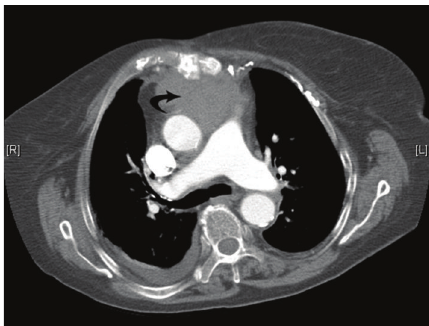
Figure 2: Axial slice from contrast-enhanced CT study demonstrat- ing direct communication and erosion of the abscess cavity into the anterior ascending aorta resulting in a localised peri-aortic area of contrast extravasation (black